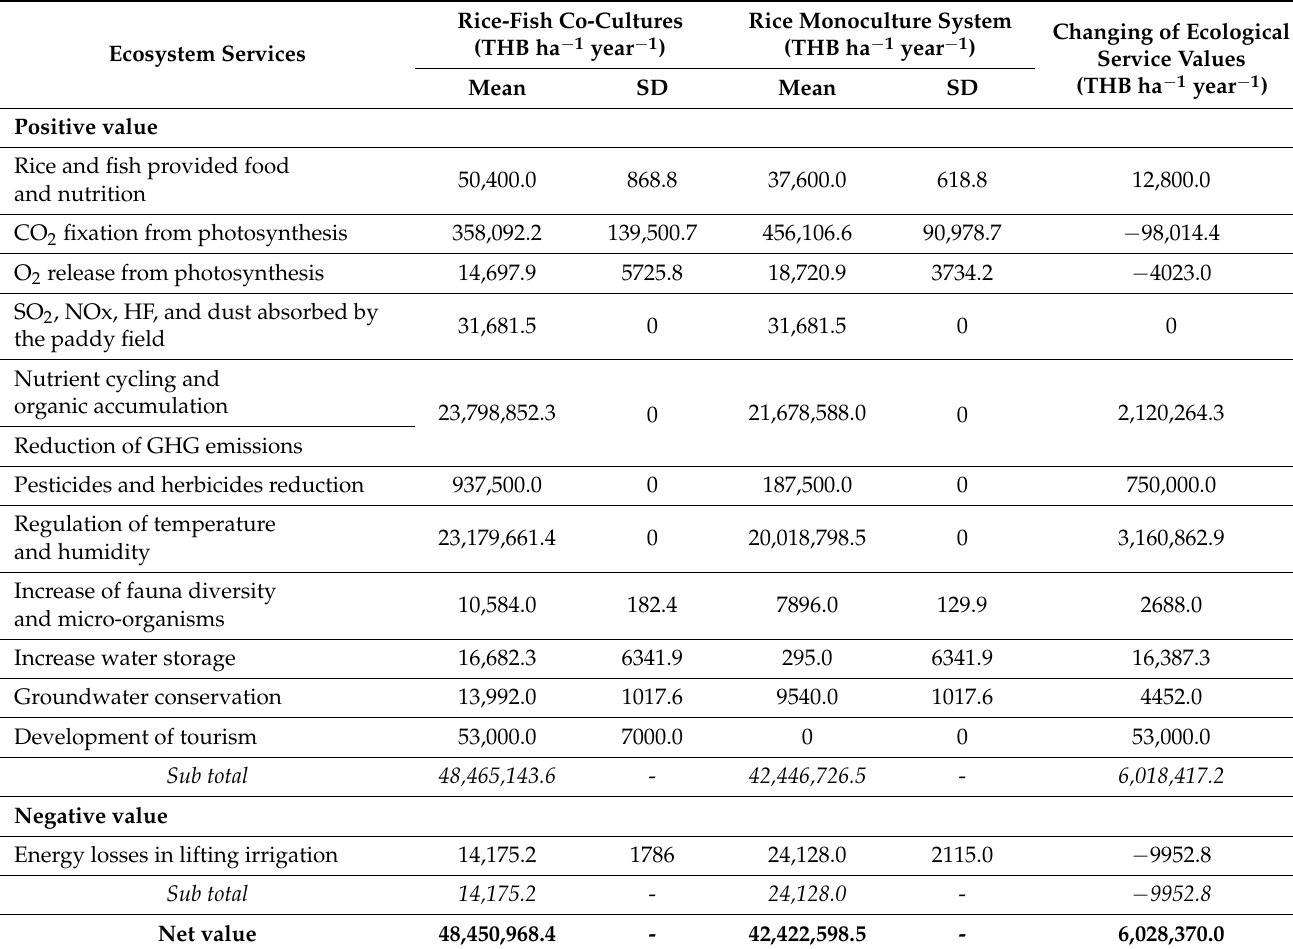
Table 3. Ecosystem service values of rice–fish co-culture and rice monoculture systems during 2020–2021.